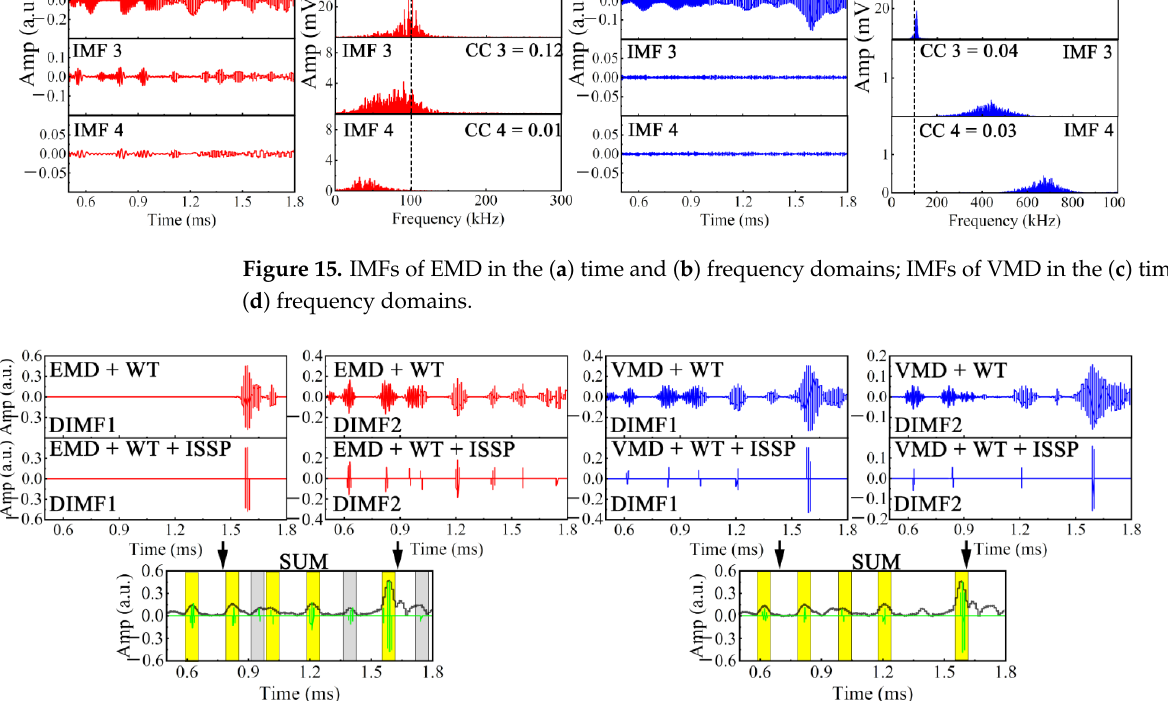
Figure 16. E/VMD + WT + ISSP processing results of EUS 4.